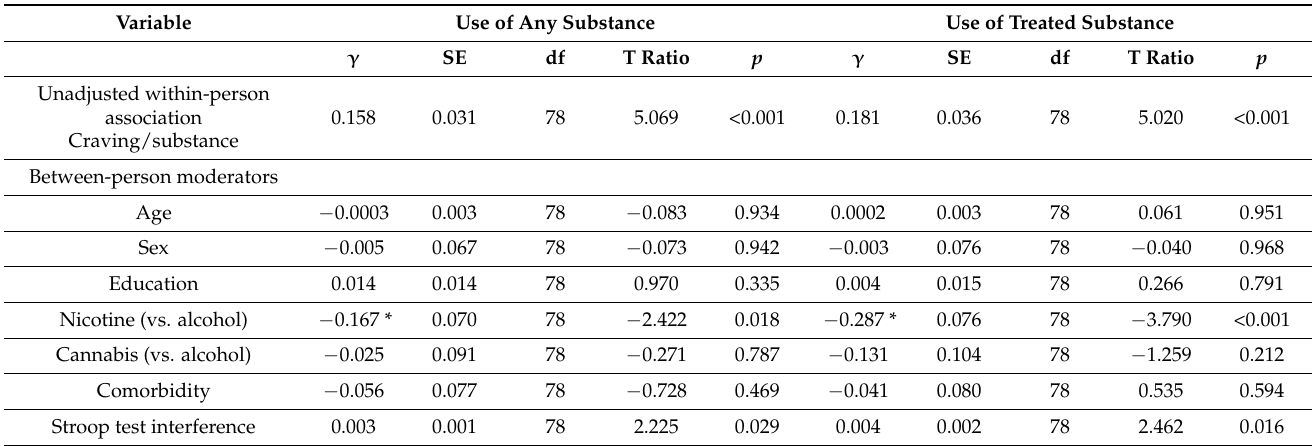
Table 2. Within-person associations of craving and use of any substance by resistance to interference (Stroop